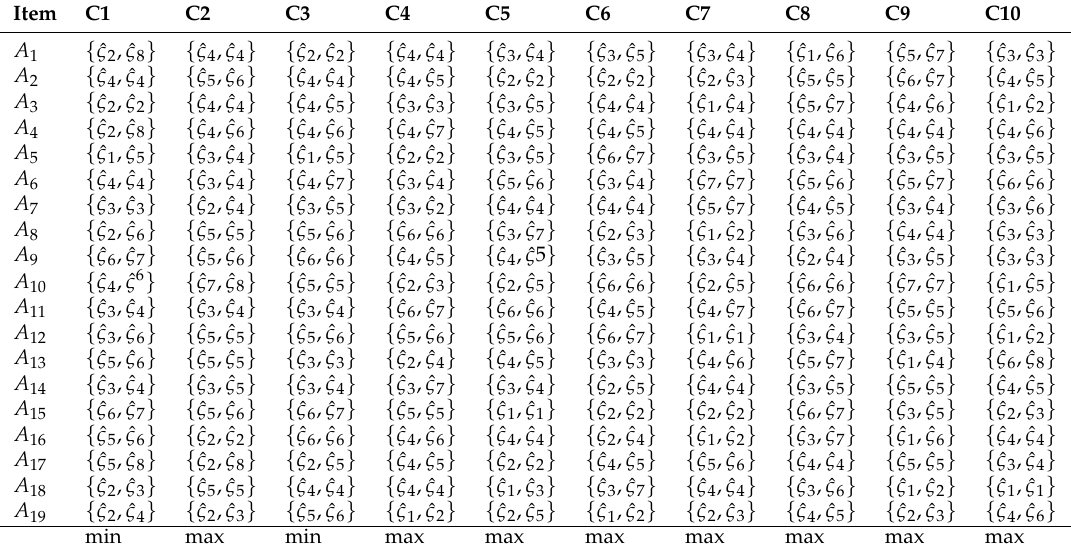
Table 4. Decision hesitant aggregated matrix